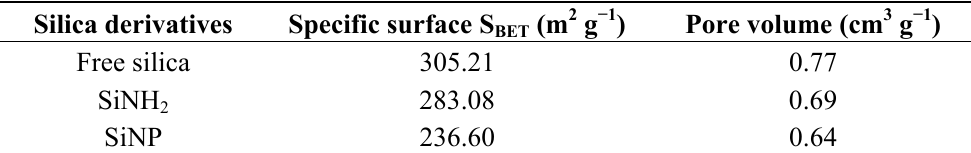
Table 1. Physical properties of silica